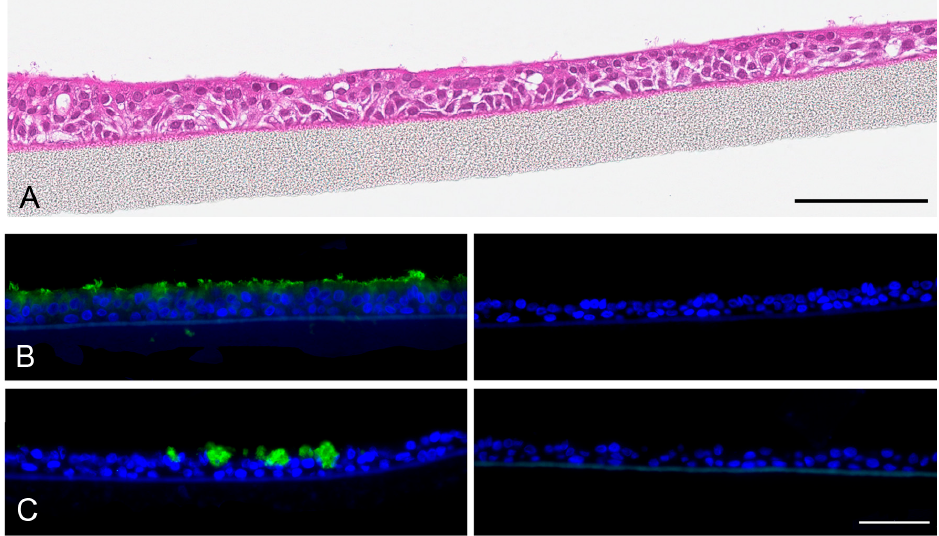
Figure 3. Morphology of EpiAirway™ tissues according to hemalaun staining ( A ) and cellular composition according to immunochistochemical staining. Scale bar: 100 µ m. Anti- α -tubulin ( B ) and anti-mucin 5AC ( C ) staining (green) for visualization of bronchial epithelial and goblet cells. Controls with mouse IgG instead of primary antibody are shown on the right side. Nuclei are counterstained with Hoechst 33342 (blue). Scale bar 50 µ m.